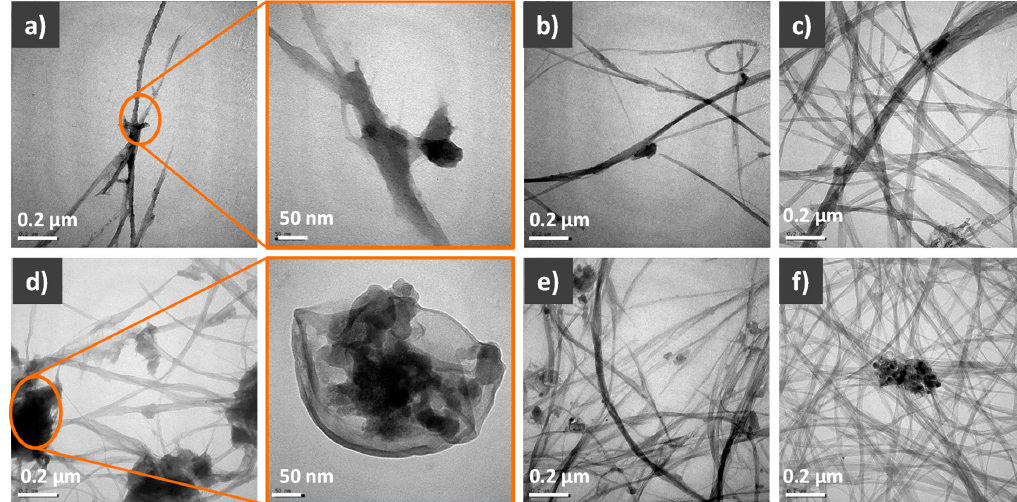
Figure 5. Transmission electron microscopy (TEM) images of the composites for P(TBT-Pt)/SWCNT